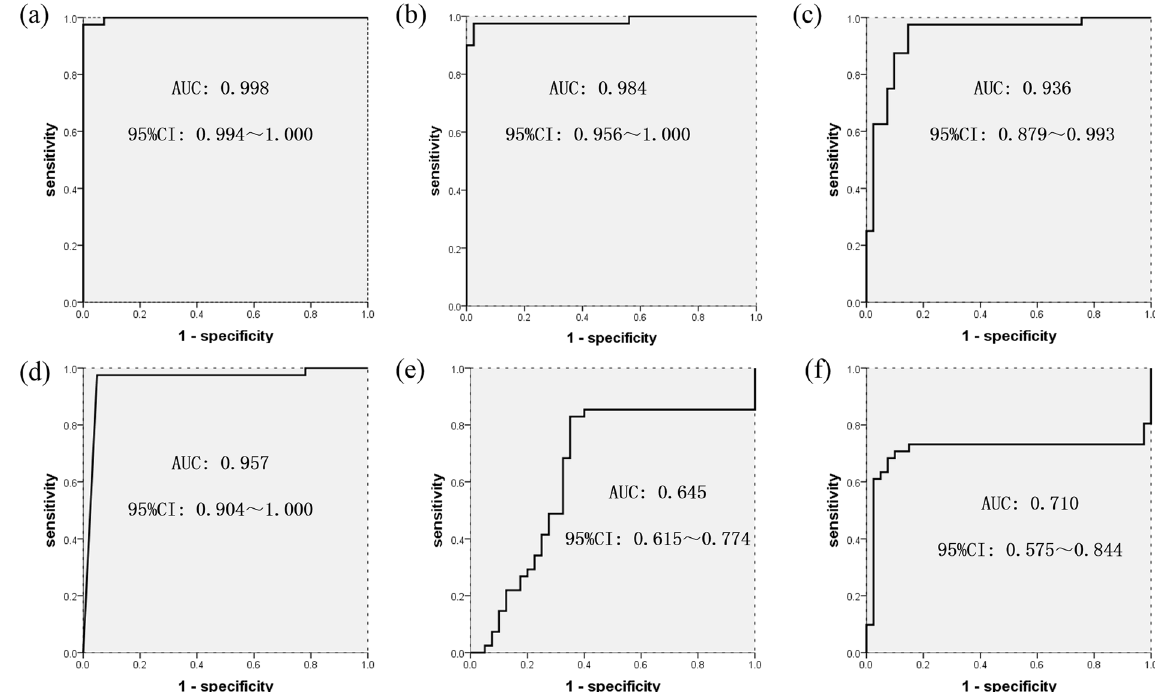
Figure 4. ROC curves of six amino acids; ( a – f ) the AUC and 95% CI of dimethylglycine (DMG), proline, isoleucine, arginine, asparagine, and glutamine, respectively; * AUC, area under the receiver operating characteristic (ROC) curve; 95% CI, 95% confidence interval.